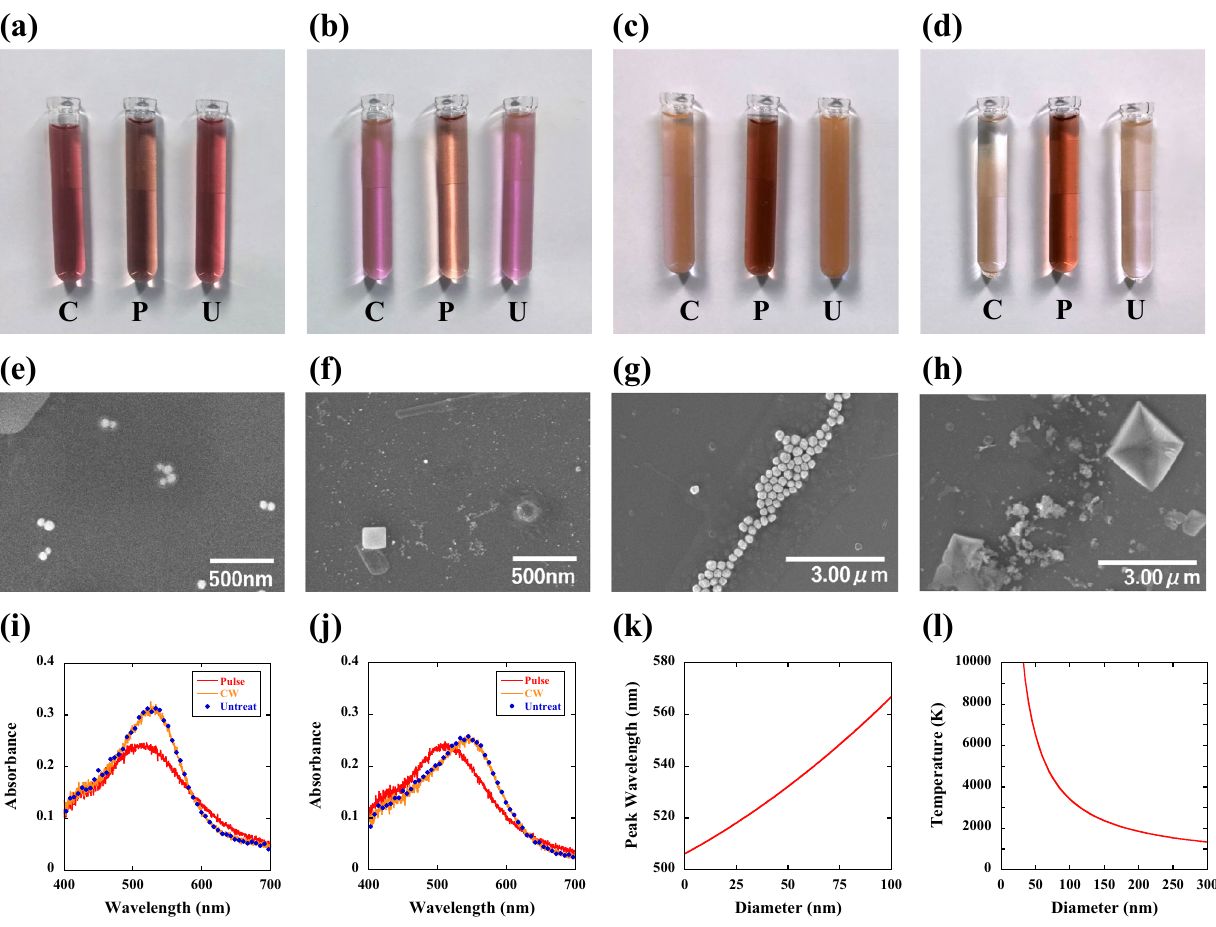
Figure 2. Physical state observations of gold nanoparticles by pulse laser irradiation. ( a–d ) Colour change of Au nanocolloid suspensions by pulsed laser irradiation for diameters of ( a ) 40 nm, ( b ) 80 nm, ( c ) 150 nm, and ( d ) 300 nm. Here, C denotes the suspension after continuous wave laser irradiation, P denotes the suspension after pulsed laser irradiation, and U denotes the suspension before laser irradiation (control). ( e – h ) Scanning electron microscopy images of the Au nanoparticles before and after pulse irradiation. ( e ) 40 nm nanoparticles before irradiation, ( f ) 40 nm nanoparticles after irradiation, ( g ) 300 nm nanoparticles before irradiation, and ( h ) 300 nm nanoparticles after irradiation. ( i - j ) Optical absorption spectra for ( i ) 40 nm nanoparticles and ( j ) 80 nm nanoparticles. Here, the red line shows the spectrum treated by pulsed laser irradiation, the orange line is the spectrum treated by CW laser irradiation, and blue dots are the spectrum of untreated samples. ( k ) Experimentally determined relation between the diameter of Au nanoparticles and the peak value of the absorbance spectrum. ( l ) Theoretically calculated maximum temperatures of Au nanoparticles versus diameter. The temperature of the Au nanoparticles smaller than 300 nm exceeds the melting point (1337 K); thus, all the Au nanoparticles from 40 to 300 nm are instantaneously melted by pulsed laser